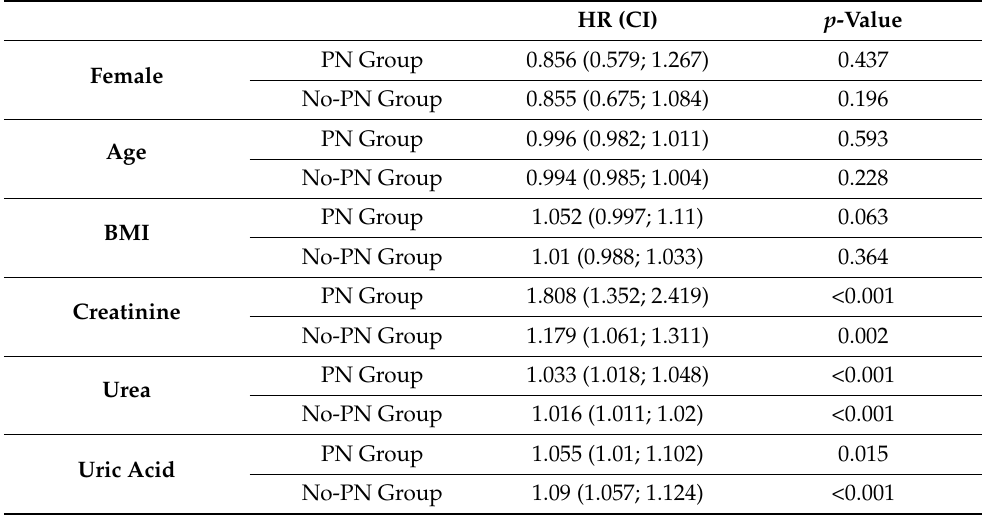
Table 3. Laboratory variables at baseline and their association with overall survival.